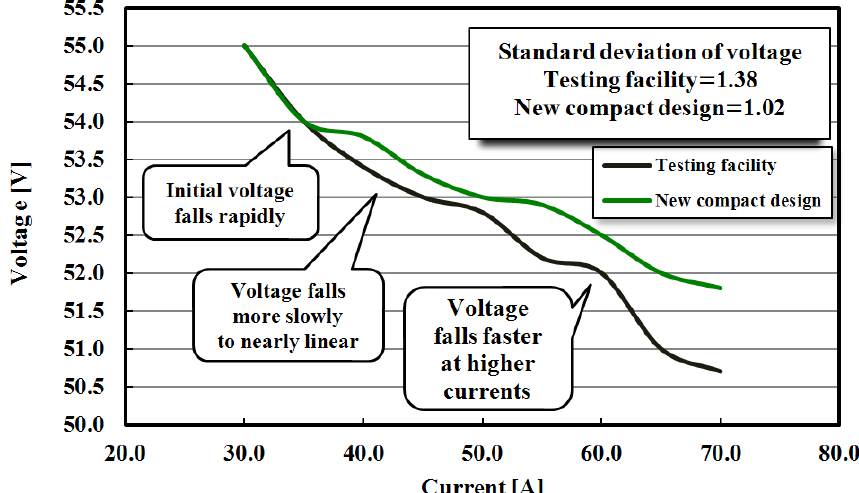
Figure 4. The performance of 5 kW fuel cell stack for the testing facility and the new compact